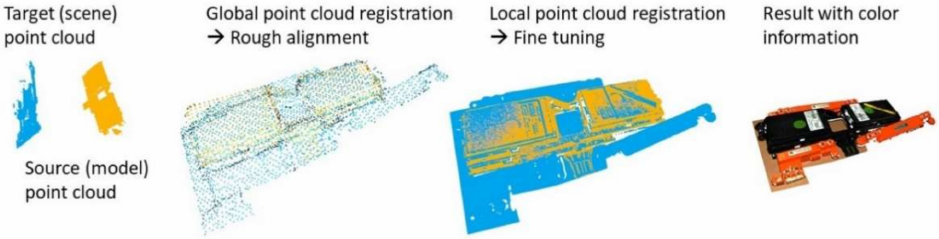
Figure 12. Matching of the misaligned source and target point clouds (exemplary depicted for BMS Slave Mounting).